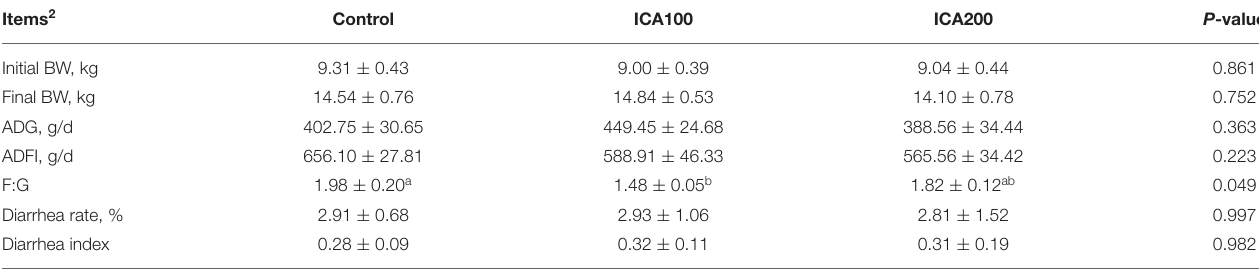
TABLE 2 | Effects of dietary ICA supplementation on the growth performance of weaned piglets 1 . Items 2